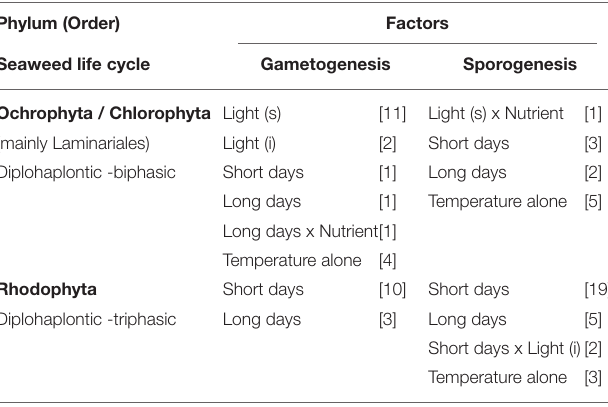
TABLE 1 | Factors associated with reproductive maturation (gametogenesis and sporogenesis) of temperate seaweeds studied found in combination with temperature for the three main phyla/life cycles studied (Chlorophyta, Ochrophyta, and